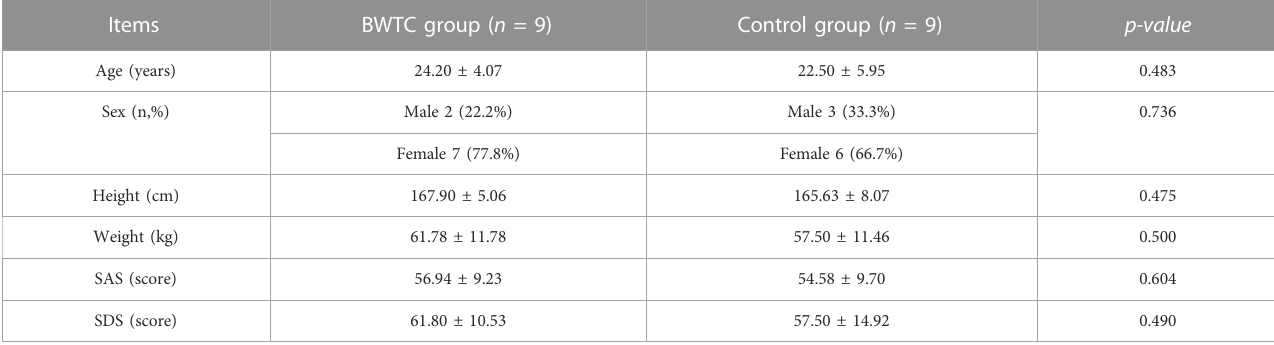
TABLE 1 Baseline sample characteristics.